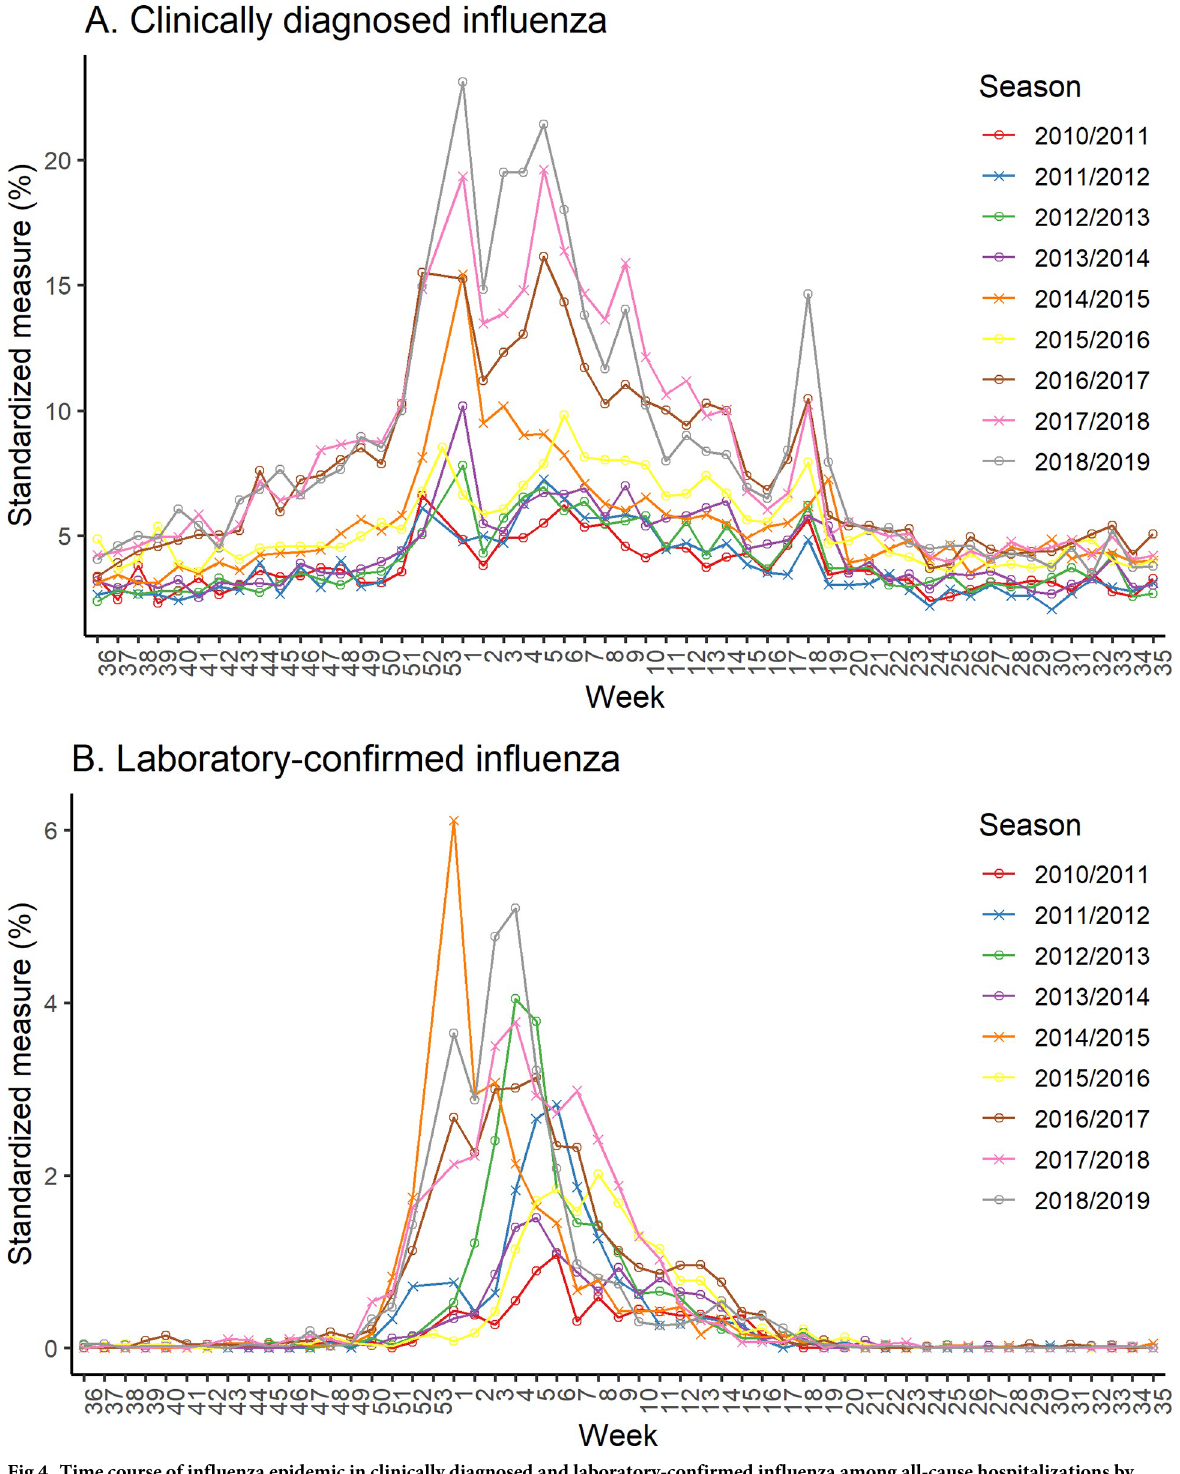
Fig 4. Time course of influenza epidemic in clinically diagnosed and laboratory-confirmed influenza among all-cause hospitalizations by season from the 2010/2011–2018/2019. ( A) clinically diagnosed influenza (CDI) (B) laboratory-confirmed influenza (LCI). The standardized measure was calculated by dividing the number of inpatient and outpatient with CDI or LCI per week by the number of all-cause hospitalizations per week. Week one started on January 1.